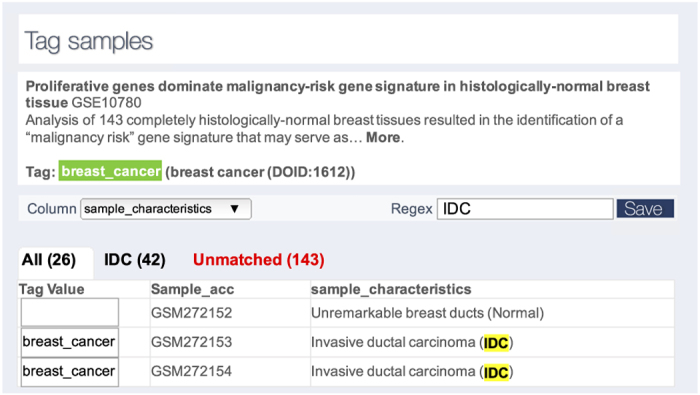
STARGEO.org curation process.The figure shows a STARGEO.org screenshot to annotate the experimental study (GSE10780) entitled ‘Proliferative genes dominate malignancy-risk gene signature in histologically-normal breast tissue’. The Tag has been mapped a-priori to the disease ontology and represents a generalized class of breast cancer (DOID:1612). To annotate samples that match to the breast_cancer Tag, the curator selected the sample_characteristics column and designed the ‘IDC’ RegEx to GEO sample descriptors. STARGEO.org automatically highlights matching samples in real-time based on the curator’s RegEx and annotates those samples with the selected Tag. This process is repeated across many different studies and different Tags to explicitly capture all relevant information that is subsequently used to perform meta-analyses.